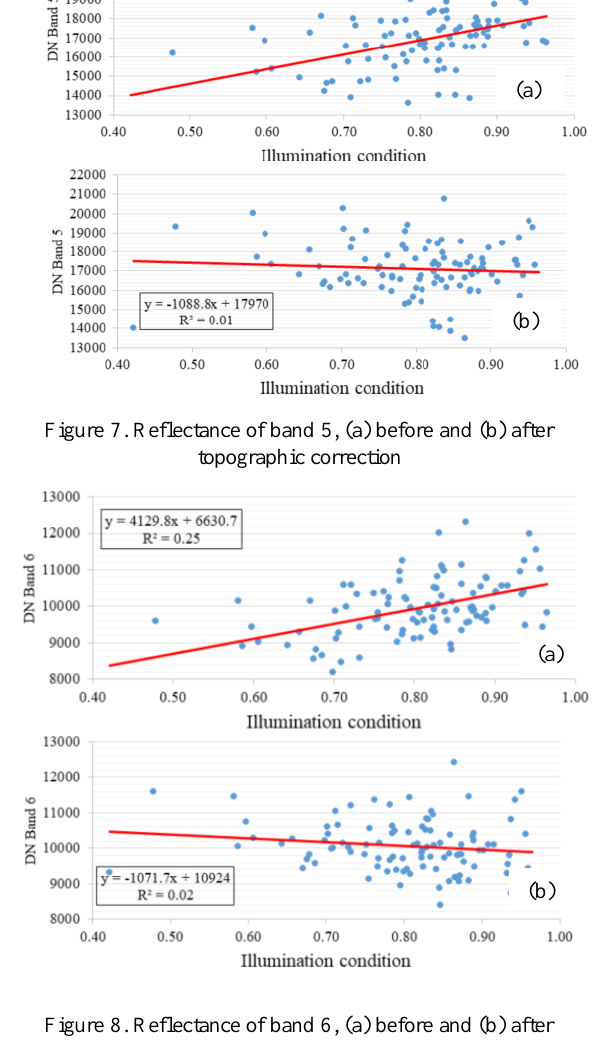
Figure 10. Value of NDVI, (a) before and (b) after topographic correction Table 1.Statistical parameter comparison of NDVI before